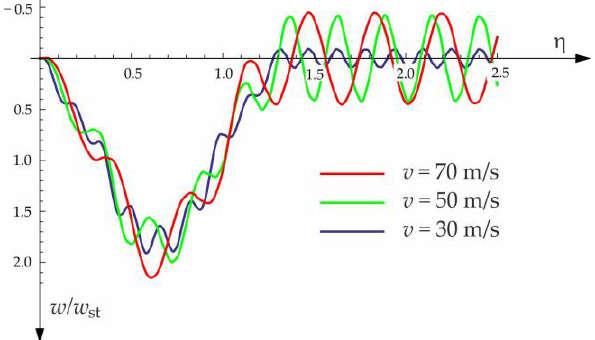
Figure 12. Influence of moving force velocity on the deflection of the midpoint of the beam on three-parameter Vlasov foundation subjected to the group of two forces moving at a constant distance a = 1.5 m.